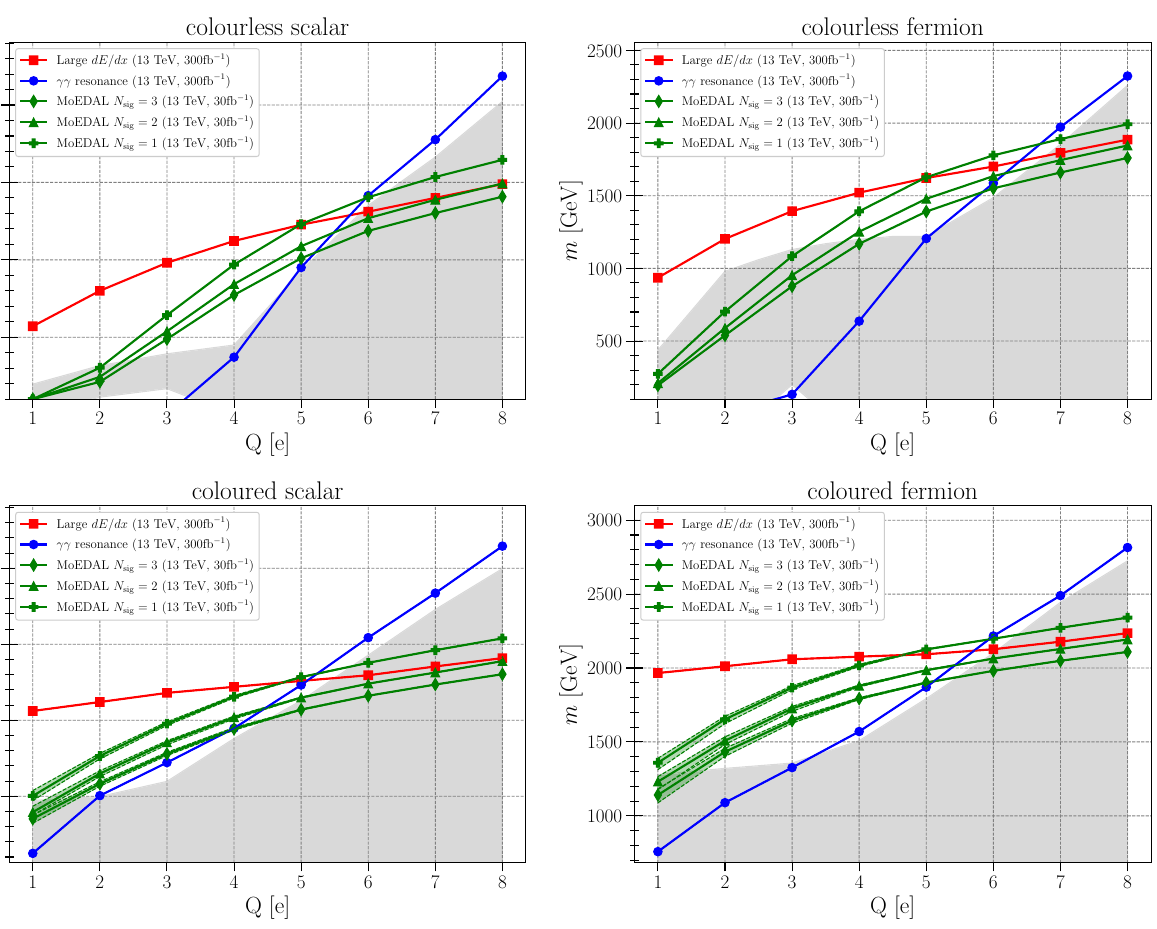
Fig. 12 E on BSM particles: colourless scalars (top left), colour- less fermions (top right), coloured scalars (bottom left) and coloured fermions (bottom right); for Run-3 LHC experiments. Integrated lumi- nosity for ATLAS/CMS was L = 300 fb − 1 and L = 30 fb − 1 for